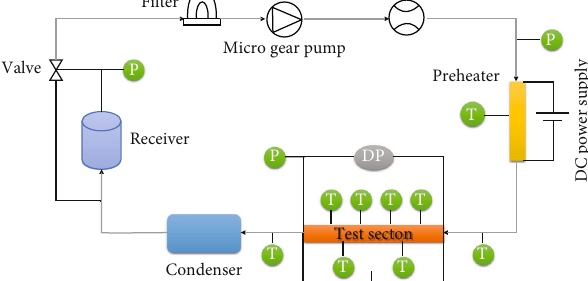
Table 2: Properties of water and nanoparticle (298.15K).